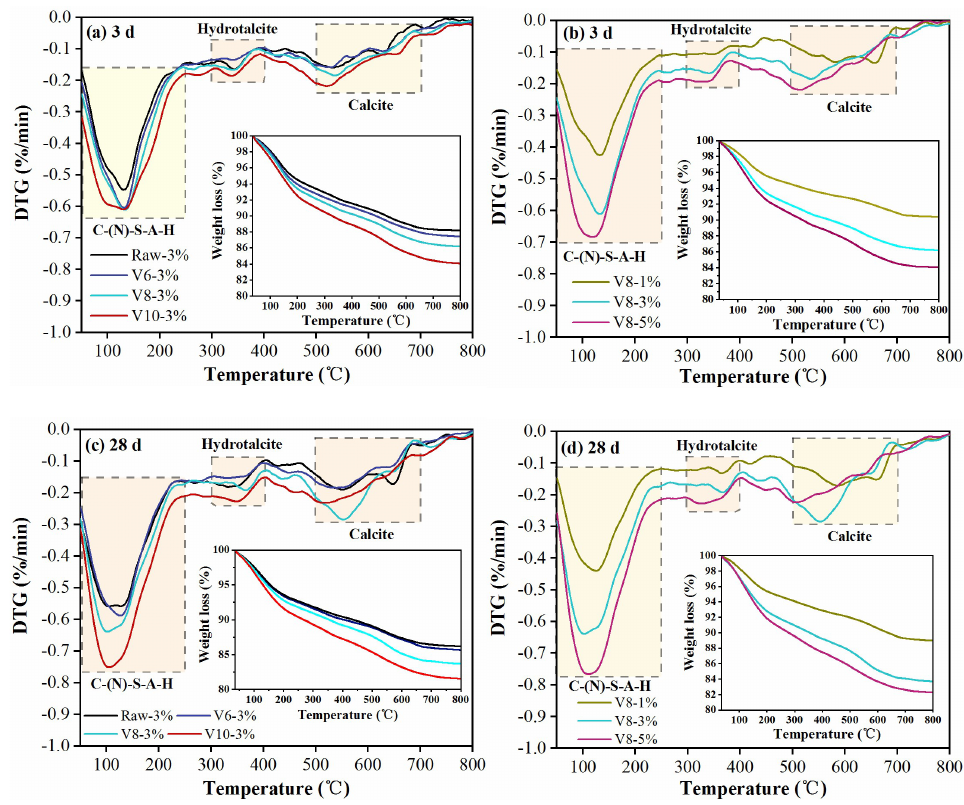
Figure 9. TG−DTG results of hardened specimens at 3 d and 28